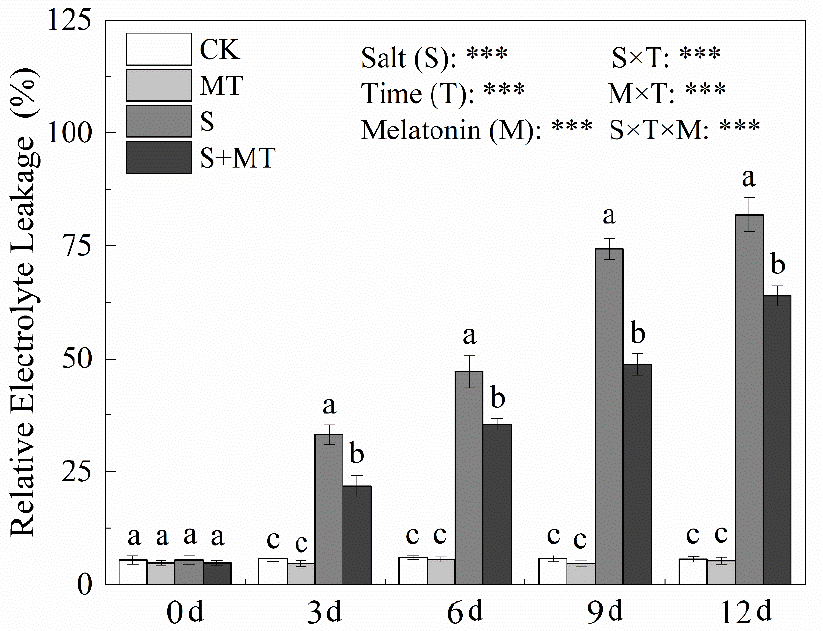
Figure 2. Effects of exogenous melatonin on relative electrolyte leakage (%) in C. leucochlora seedlings under salt stress. The error bars represent the standard deviation. Significance levels are presented for each main effect or interaction. *** p < 0.001.